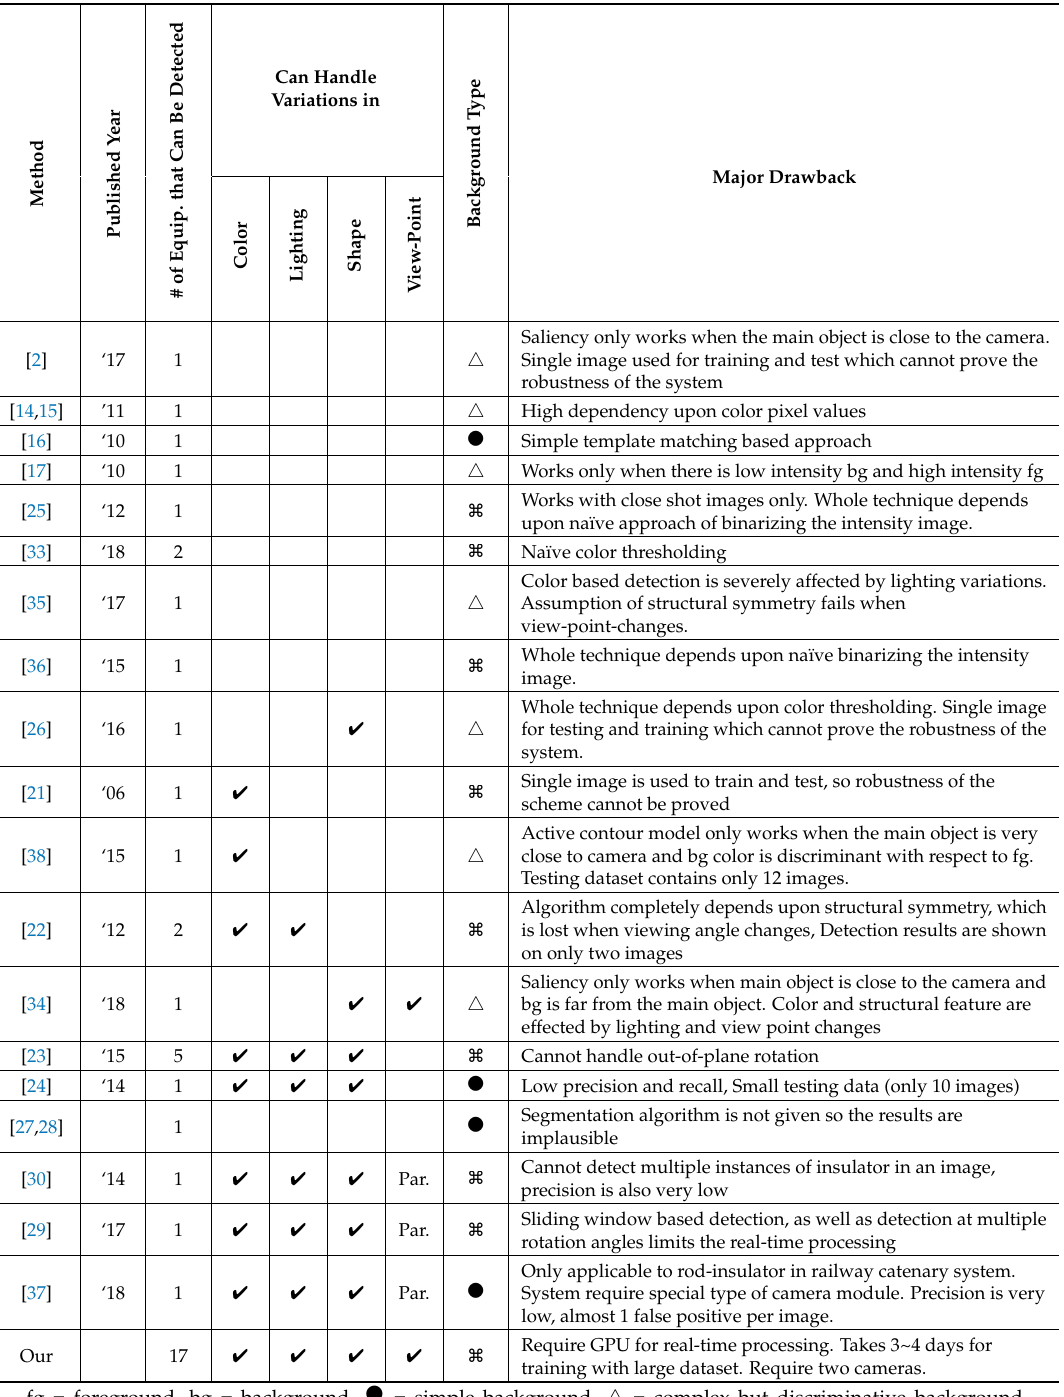
Table 1. Summary of the related work.